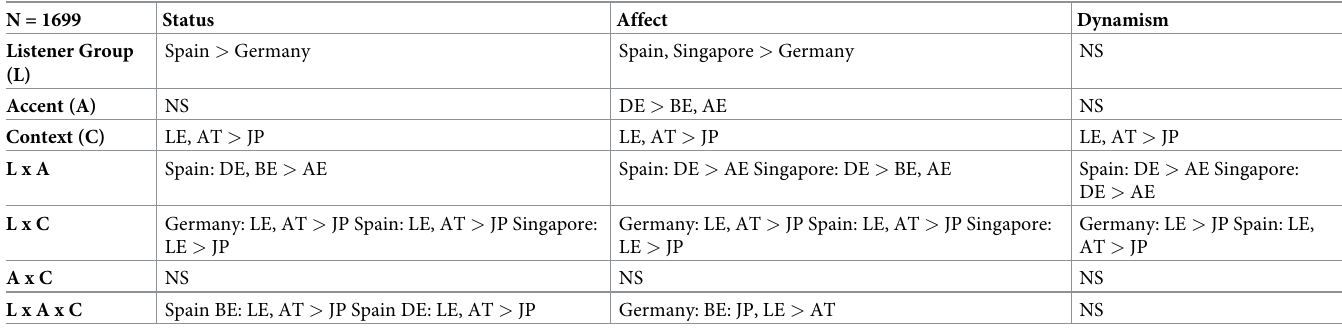
Table 4. Summary results speaker evaluations (Status, Affect,